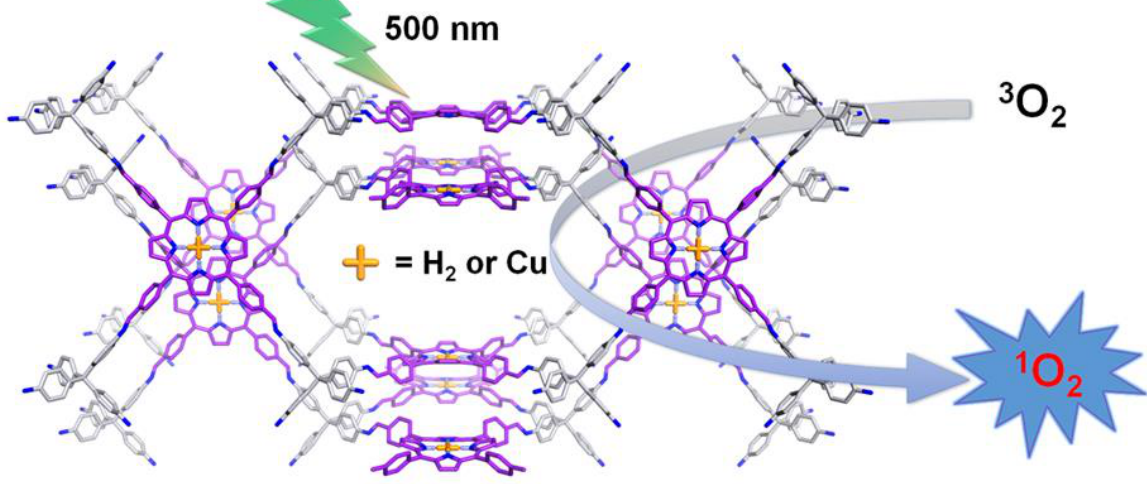
Figure 6. Crystal structure of 3D CuPor-COF. Reprinted (adapted) with permission from [24]. Copyright {2017} American Chemical Society.